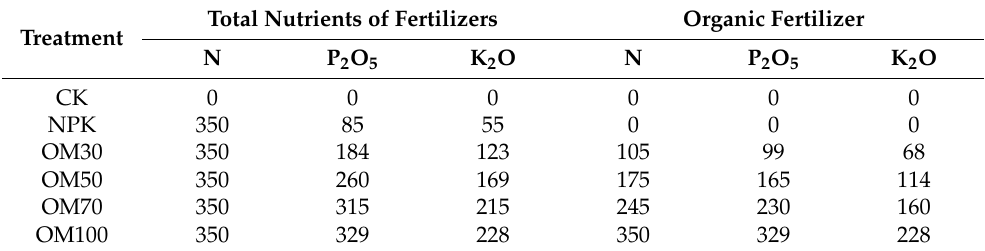
Table 1. The quantity of the applied fertilizers for each plot (kg hm − 2 ). Total Nutrients of Fertilizers Organic Fertilizer Treatment